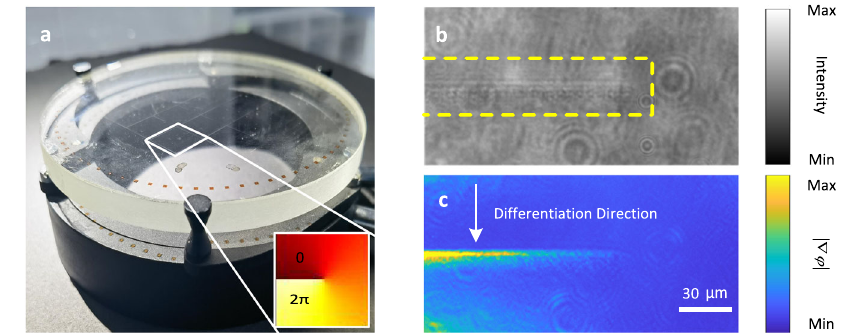
Fig. 6 | The fi rst-order spatial differentiation for phase gradient information. a Photograph of a standard spiral phase plate, where the inset shows the spiral phase distribution. b Bright fi eld image of the phase-discontinuous line on one